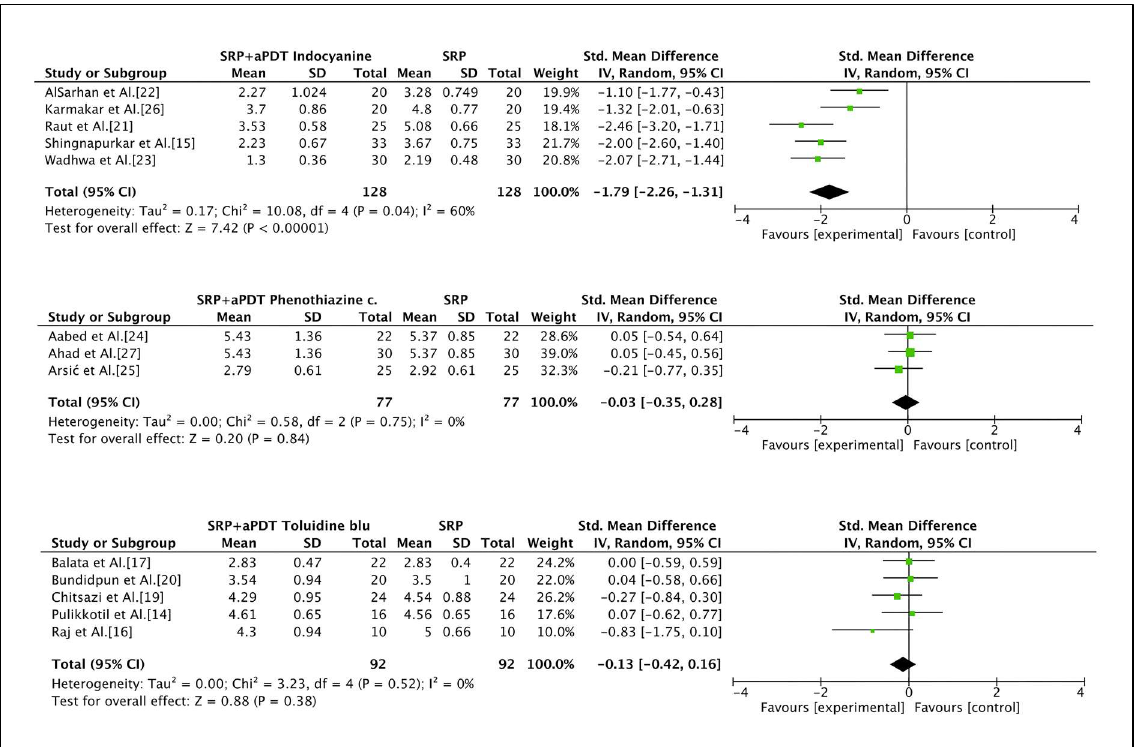
Figure 2. Forest plot showing post therapy PPD (≥5 mm) comparing the effect of adjunctive antimicrobial photodynamic therapy (aPDT) vs. scaling and root planing (SRP) divided into subgroups.